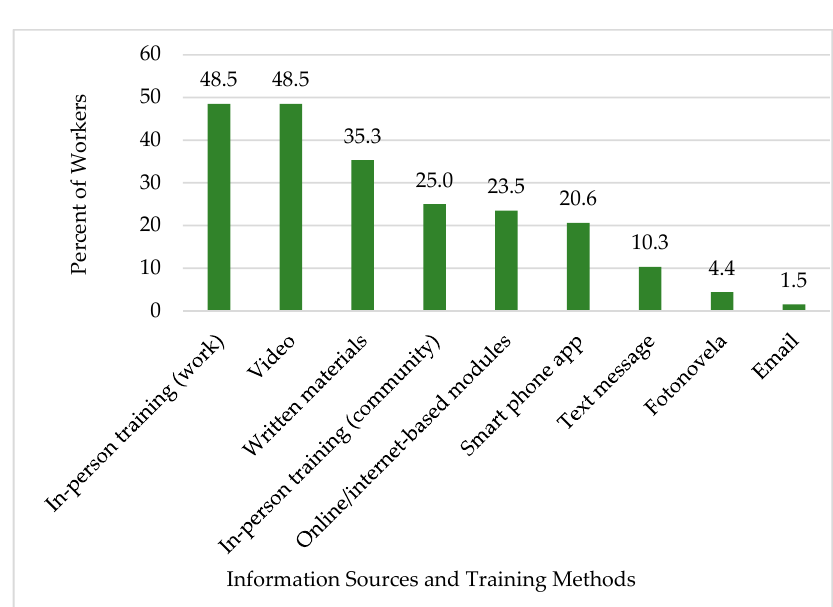
Figure 2. Preferred information sources and training methods.